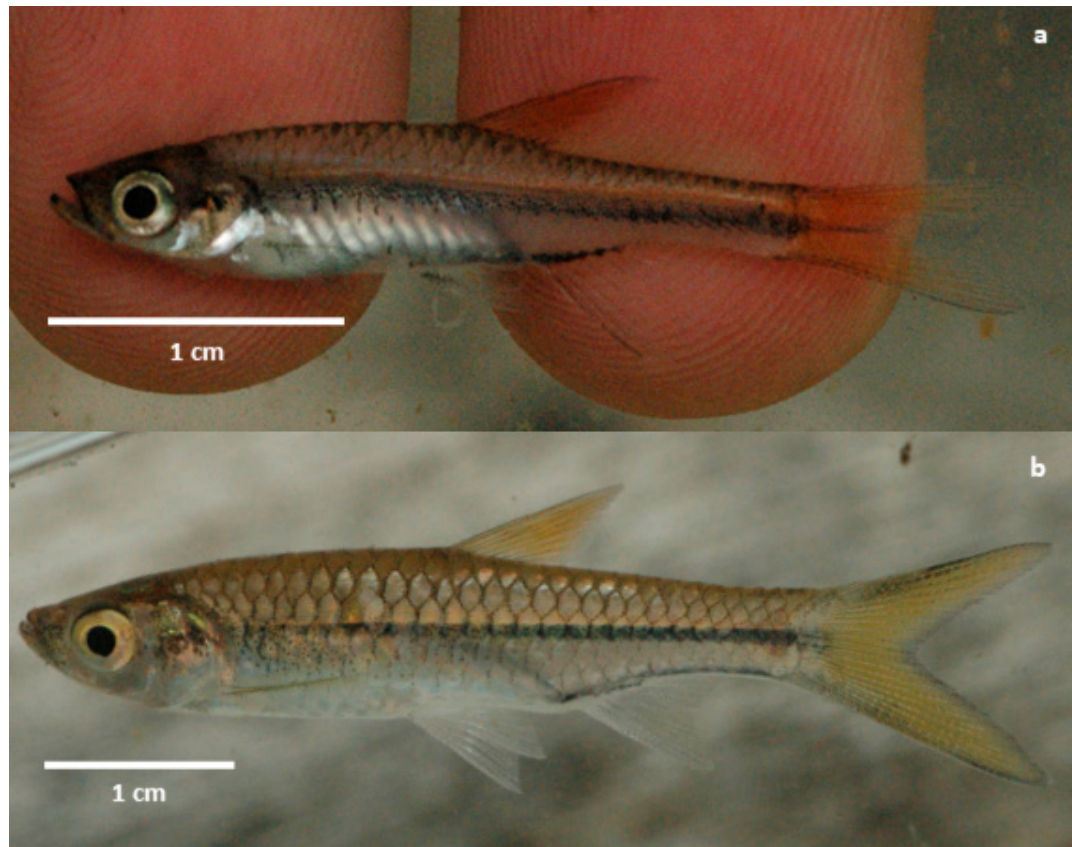
Figure 6. ( a ) Trigonopoma sp. from the Mesangat wetlands differs from its congeners in coloration (reddish fins vs. hyaline fins) and the lateral stripe (thinner than in T. gracile ; extending to median caudal-fin rays vs. ending at caudal-fin base in T. pauciperforatum ). Picture is mirrored. ( b ) Rasbora cf. hubbsi from the Mesangat wetlands differs in coloration (faded dark edges along the entire caudal-fin margin and a distinct yellowish caudal fin vs. hyaline) from the nominal species. Picture is mirrored.